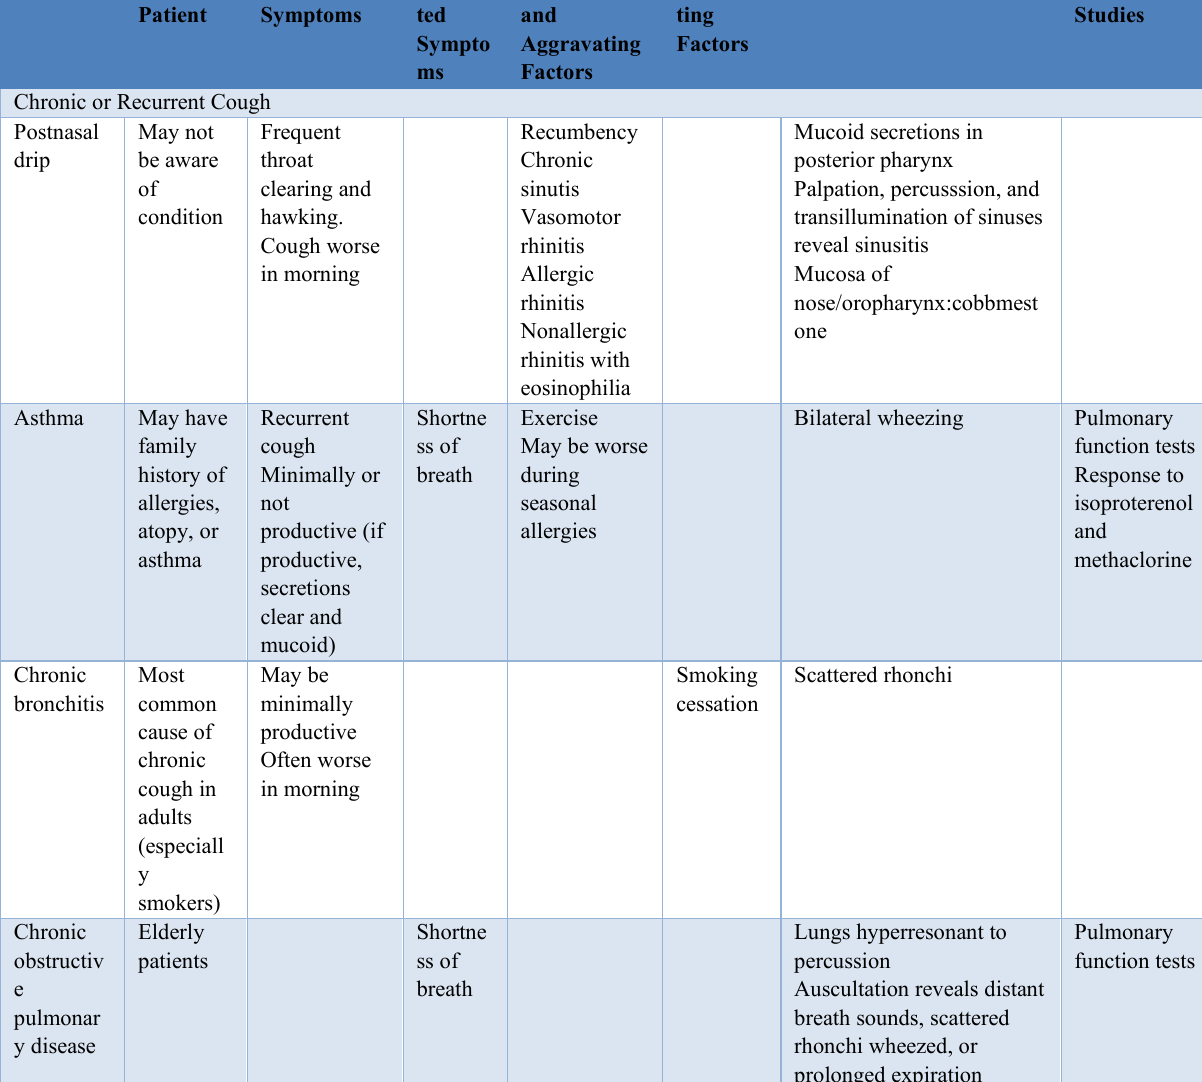
Table 1. Table of Differential Diagnosis of